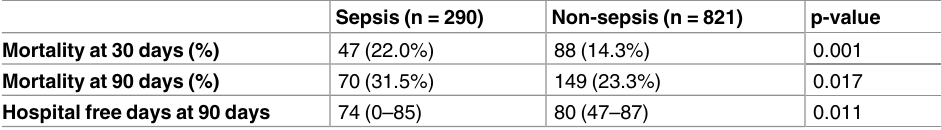
non-sepsis patients (Table 1). At 90 days significantly more patients in the sepsis group had died (31.5% vs. 23.3%, respectively). Patients suffering from sepsis had also significantly less hospital free days at 90-days compared to non-sepsis patients (Table 2). In the multivariable logistic regression model, National Early Warning Score, history of dia- betes, COPD, heart failure, malignancy and current or previous smoking habits were identified as independent variables suggesting the diagnosis of sepsis (Table 3). Table 2. Patient outcomes in sepsis and non-sepsis groups